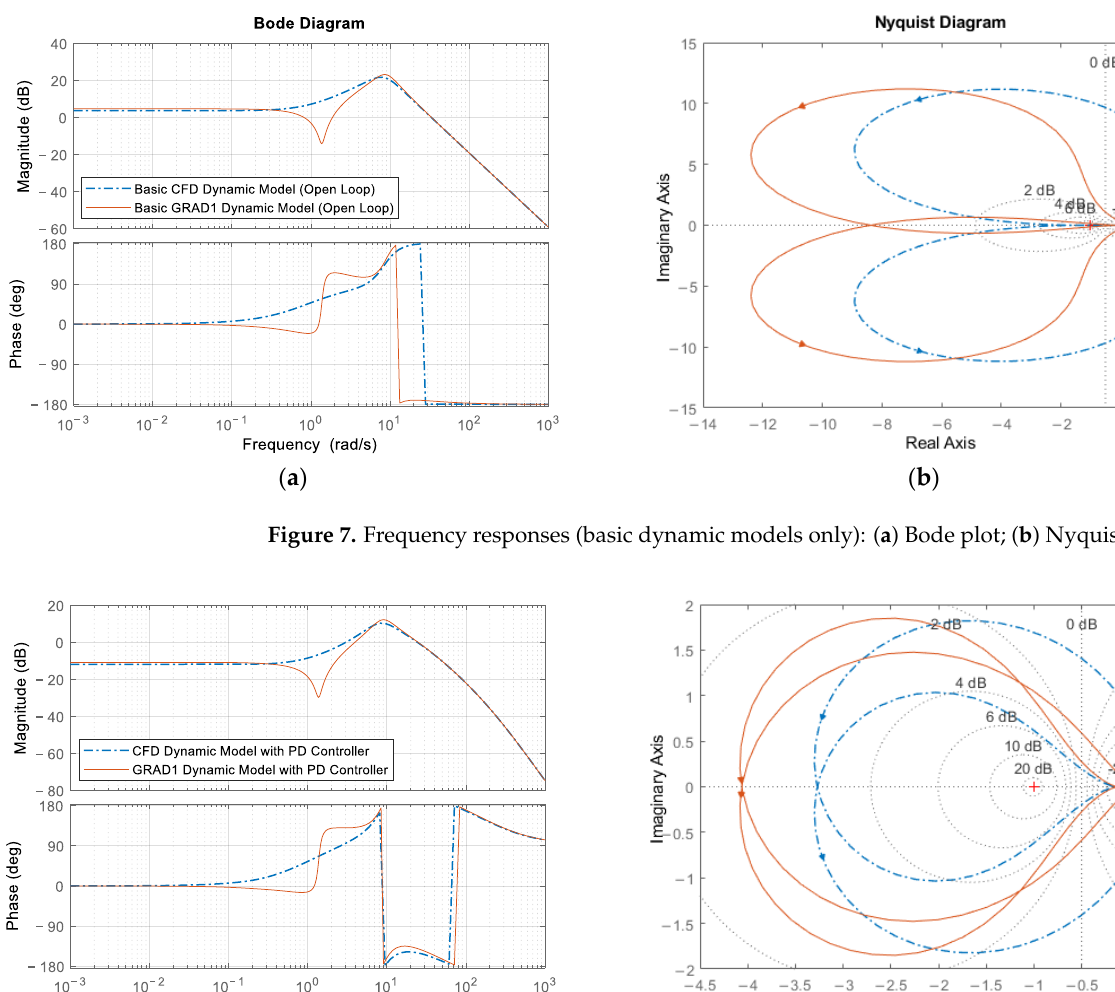
Figure 7. Frequency responses (basic dynamic models only): ( a ) Bode plot; ( b ) Nyquist diagram.